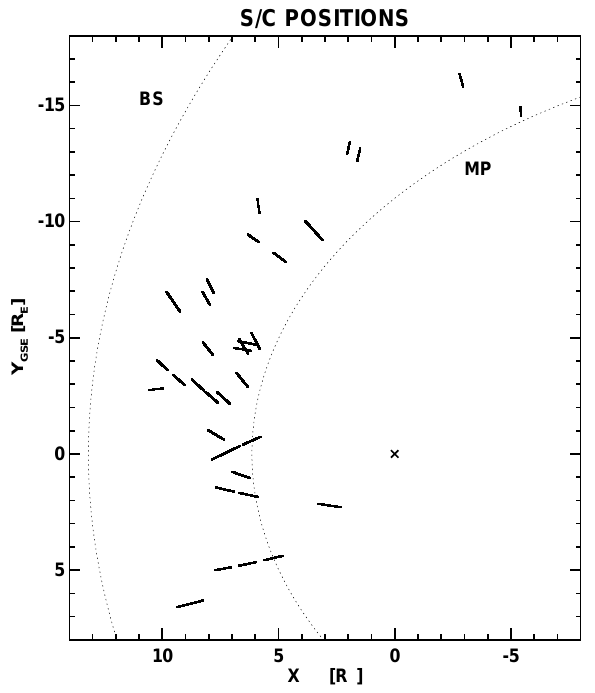
Fig. 2. Positions r B of the selected time intervals displayed in the ( X GSE ,Y GSE )-plane. The dotted lines mark an estimated location of the magnetopause and bow shock.